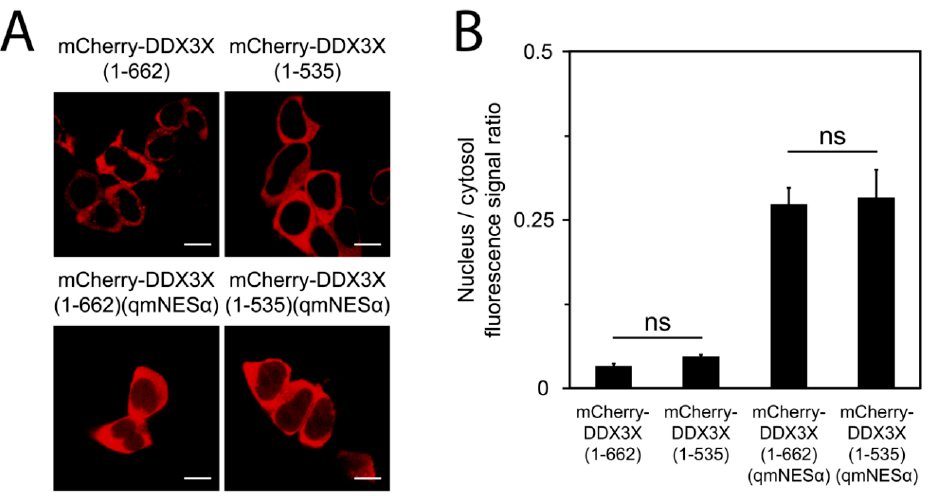
Figure 2. The C-terminal tail is dispensable for the nucleocytoplasmic distribution of DDX3X. ( A ) HEK-293T cells transfected to express mCherry-DDX3X(1–662) or mCherry-DDX3X(1–535), harboring a wild-type or defective NES, visualized by live CLSM. Scale bar = 10 µ m. ( B ) Quantitation of the nuclear-to-cytosolic fluorescence signal ratio (Fn / c) of cells shown in panel A. Results represent the mean ± SEM ( n = 50). Student’s t -test for significance with Holm–Sidak multiple comparisons test for significance; ns, not